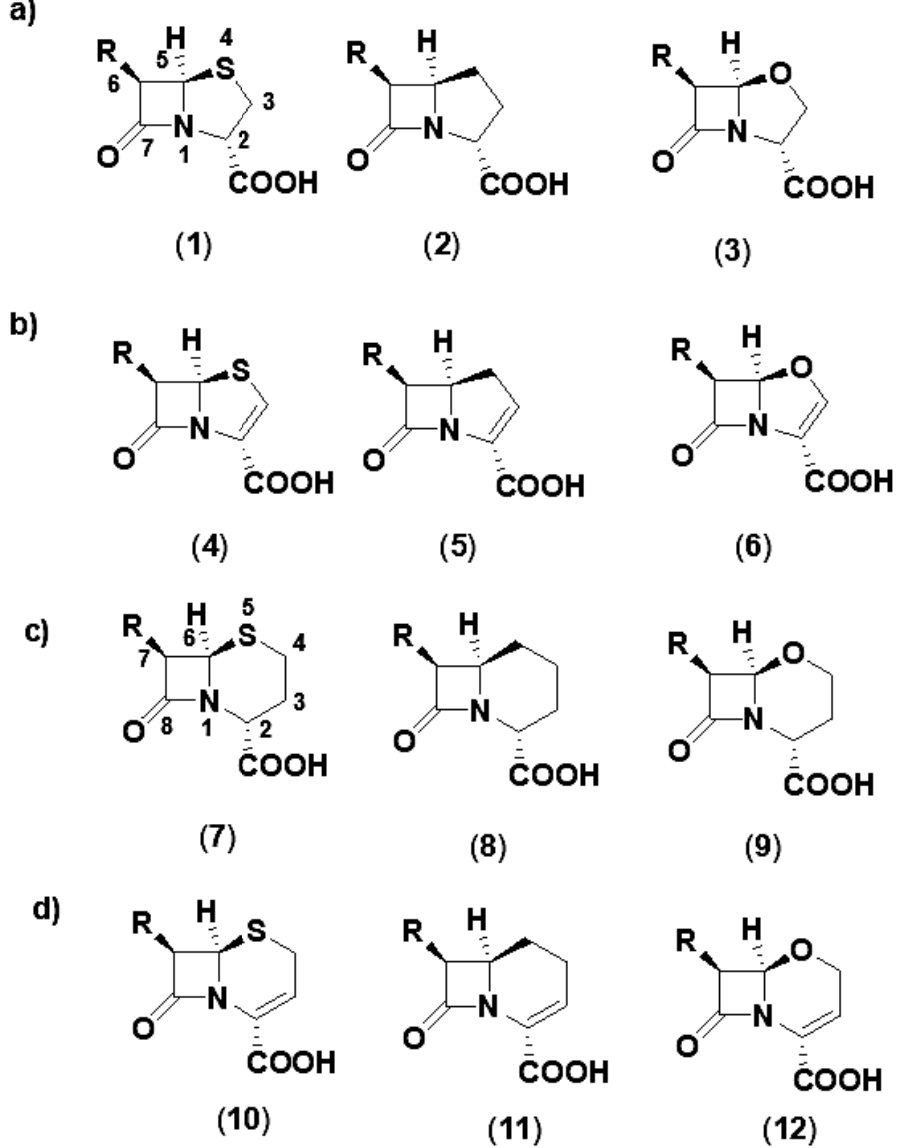
Figure 2. β-lactam core structures, drawn using the ChemDraw Ultra 7.0 software (Chem Office 2002), with the correct numbering indicate the basic ring systems. Penams ( a ), penems ( b ), cepham ( c ) and cephem ( d ), including penams (1), carbapenams (2) oxapenams (3), penems (4), carbapenem (5), oxapenem (6), cephams (7), carbacepham (8), oxacepham (9), cephems (10), carbacephem (11), and oxacephem (12).